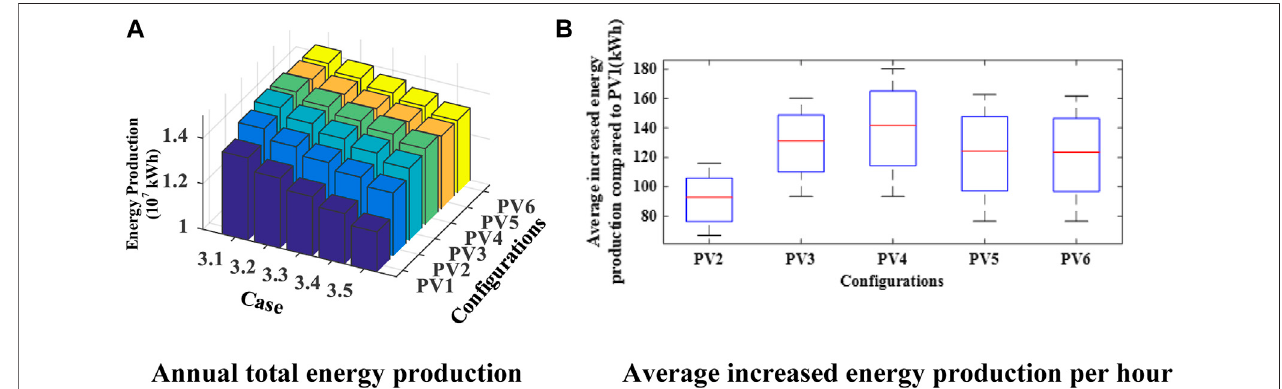
FIGURE 12 | Comparison of fi ve cases for the partial shading by clouds. (A) Annual total energy production. (B) Average increased energy production per hour.